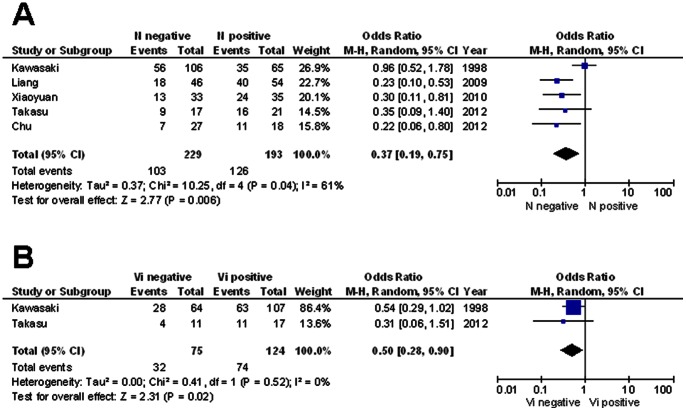
Association between survivin and lymph node metastasis or blood vessel invasion.Forest blot reflects the individual summarized OR with CI for the relationship between expression of survivin and (A) lymph node metastasis or (B) blood vessel invasion. Heterogeneity was verified by the Cochrane Q test (Chi-squared test; Chi2) and inconsistency (I2).